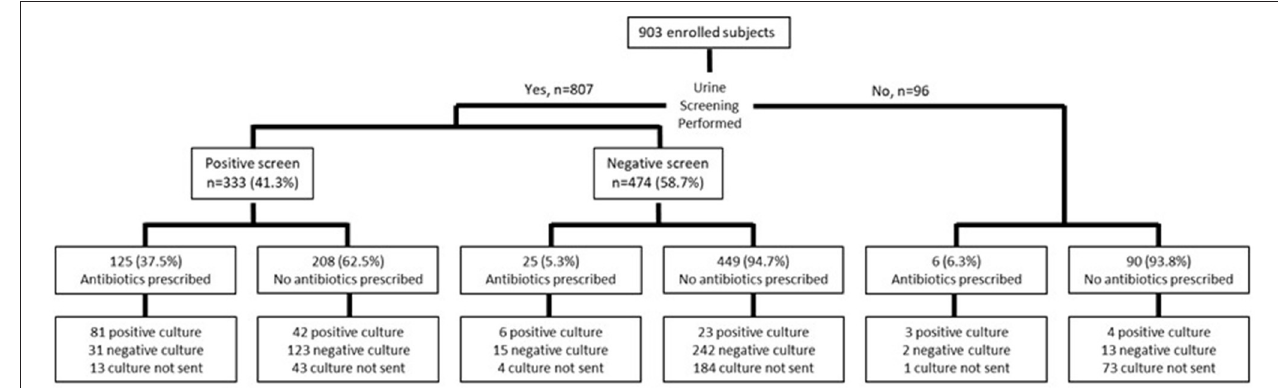
FIGURE 1 | Testing and empiric treatment in pediatric outpatients diagnosed with UTI.